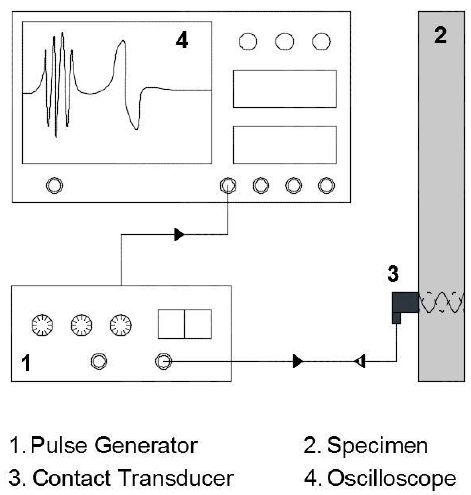
Figure 7. Experimental setup of the experiment used during UT.